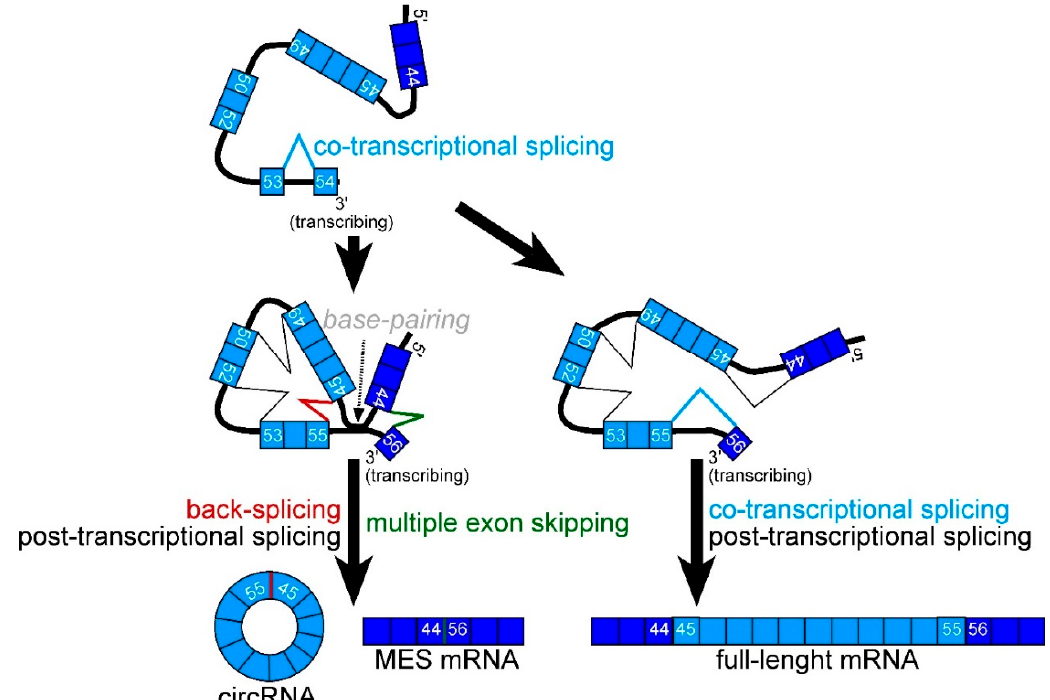
Figure 7. Potential flow of the exon 44–56-connected MES DMD mRNA and the exon 55–45 DMD circRNA. Our results and the previously reported post-transcriptional DMD pre-mRNA were overlaid onto the current model of circRNA generation in left side. Light blue lines indicate co-transcriptional splicing. Red and green indicate back-splicing and MES, respectively. Co-transcriptional introns are not shown, except for intron 53 in the upper image and intron 55 in the middle image. It was assumed that post-transcriptional intron 44 interacts with the transcribing co-transcriptional intron 55 in left side, but not in right side, for the full-length mRNA.